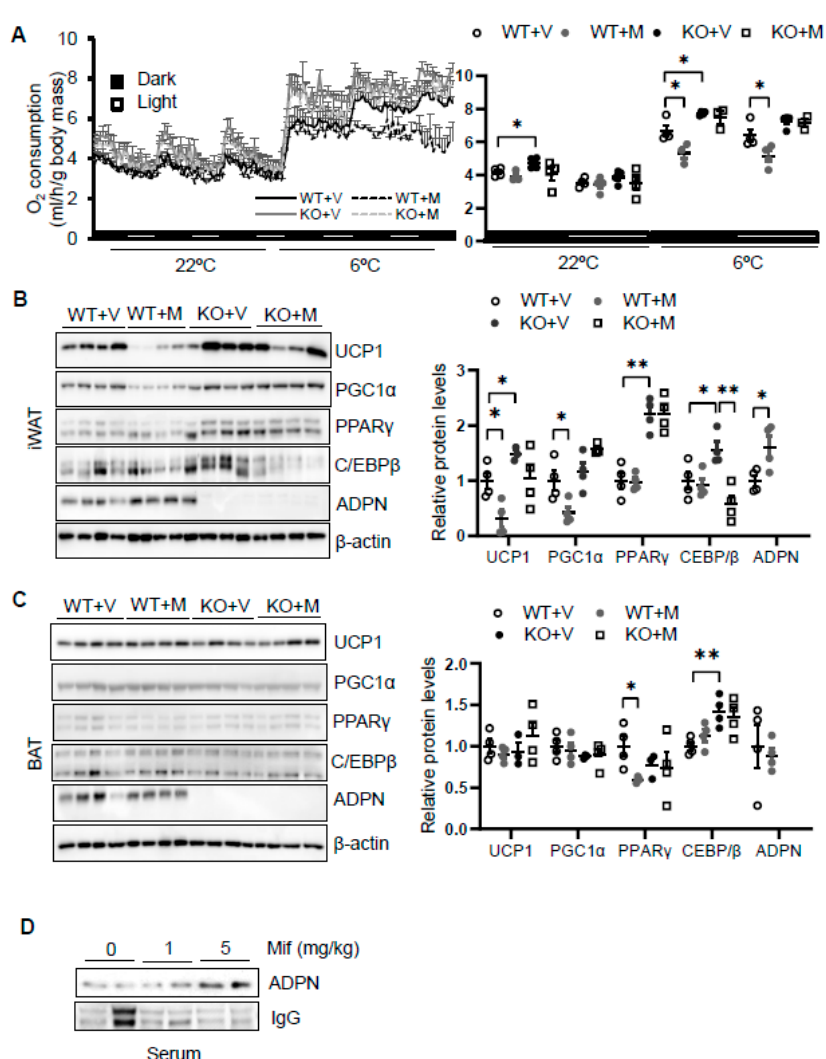
Figure 3. Blocking glucocorticoid receptor signaling inhibits cold-induced energy expenditure through upregulating adiponectin. ( A ) Administration of mifepristone suppressed acute cold- induced O 2 consumption throughout the light and dark cycle. The average O 2 consumption was normalized to whole-body mass. WT + V, wild type mice treated with vehicle; WT + M, wild type mice treated with mifepristone; KO+V, adiponectin KO mice treated with vehicle; KO+M, adiponectin KO mice treated with mifepristone. Under cold conditions, the administration of mifepristone downregulated the expression of thermogenesis genes Ucp1 and Pgc1 α , and these effects were diminished in iWAT ( B ) but not in BAT ( C ) of adiponectin KO mice. White dots, WT mice with vehicle injection ( n = 4); gray dots, WT mice with mifepristone injection ( n = 5); black dots, adiponectin KO mice with vehicle injection ( n = 4); and white square, adiponectin KO mice with mifepristone injection ( n = 4). ( D ) Treatment of mifepristone increased circulating levels of adiponectin. The data in Figure 3A–C are presented as the mean ± S.E.M. * p < 0.05, ** p <